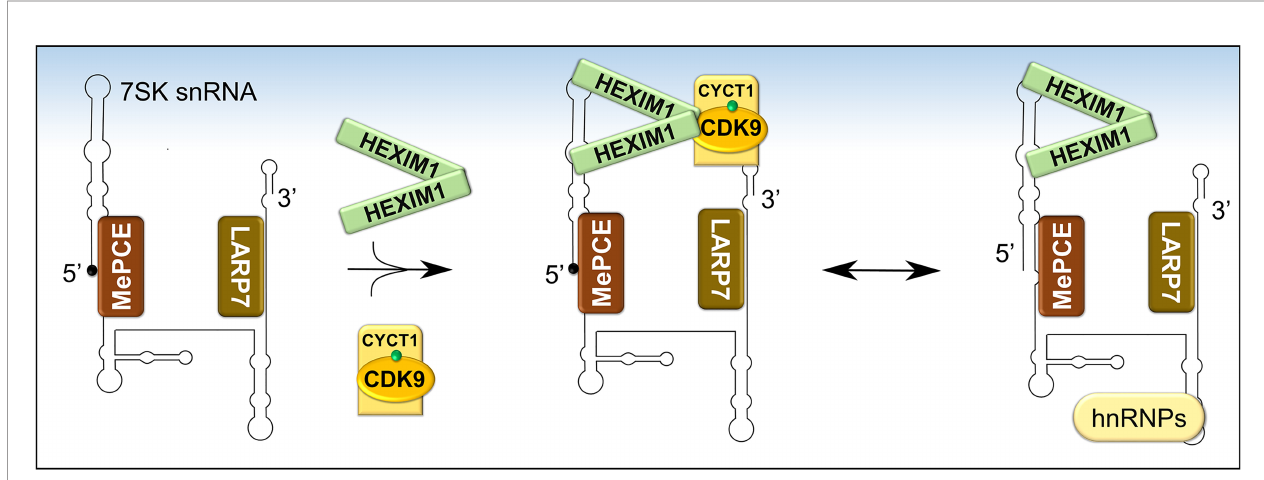
FIGURE 6 | Formation and composition of 7SK snRNP. Following the folding of 7SK RNA into a four-stem loop structure, MePCE and LARP7 bind and protect its 5 ’ and 3 ’ ends, respectively, from catalytic degradation. One mechanism of protection involves capping of the 5 ’ end of 7SK RNA by MePCE (depicted as a black dot). The stable 7SK snRNP core then binds dimers of HEXIM1 which exposes their P-TEFb binding domains. Subsequently, HEXIM1 binds activated P-TEFb (CDK9 phosphorylated on Thr186, green dot) and this inhibits its kinase activity. During transcriptional activation, P-TEFb is released and 7SK snRNP is stabilized by binding to heterogeneous nuclear ribonucleoproteins